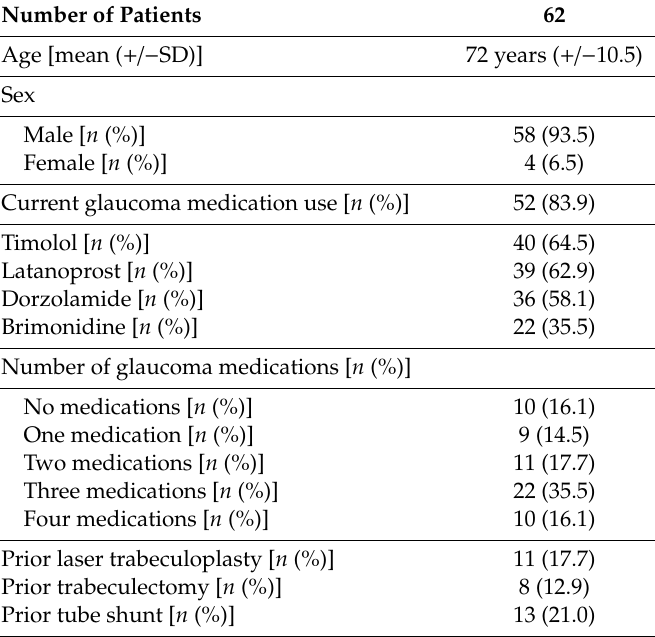
Table 1. Baseline glaucoma patient